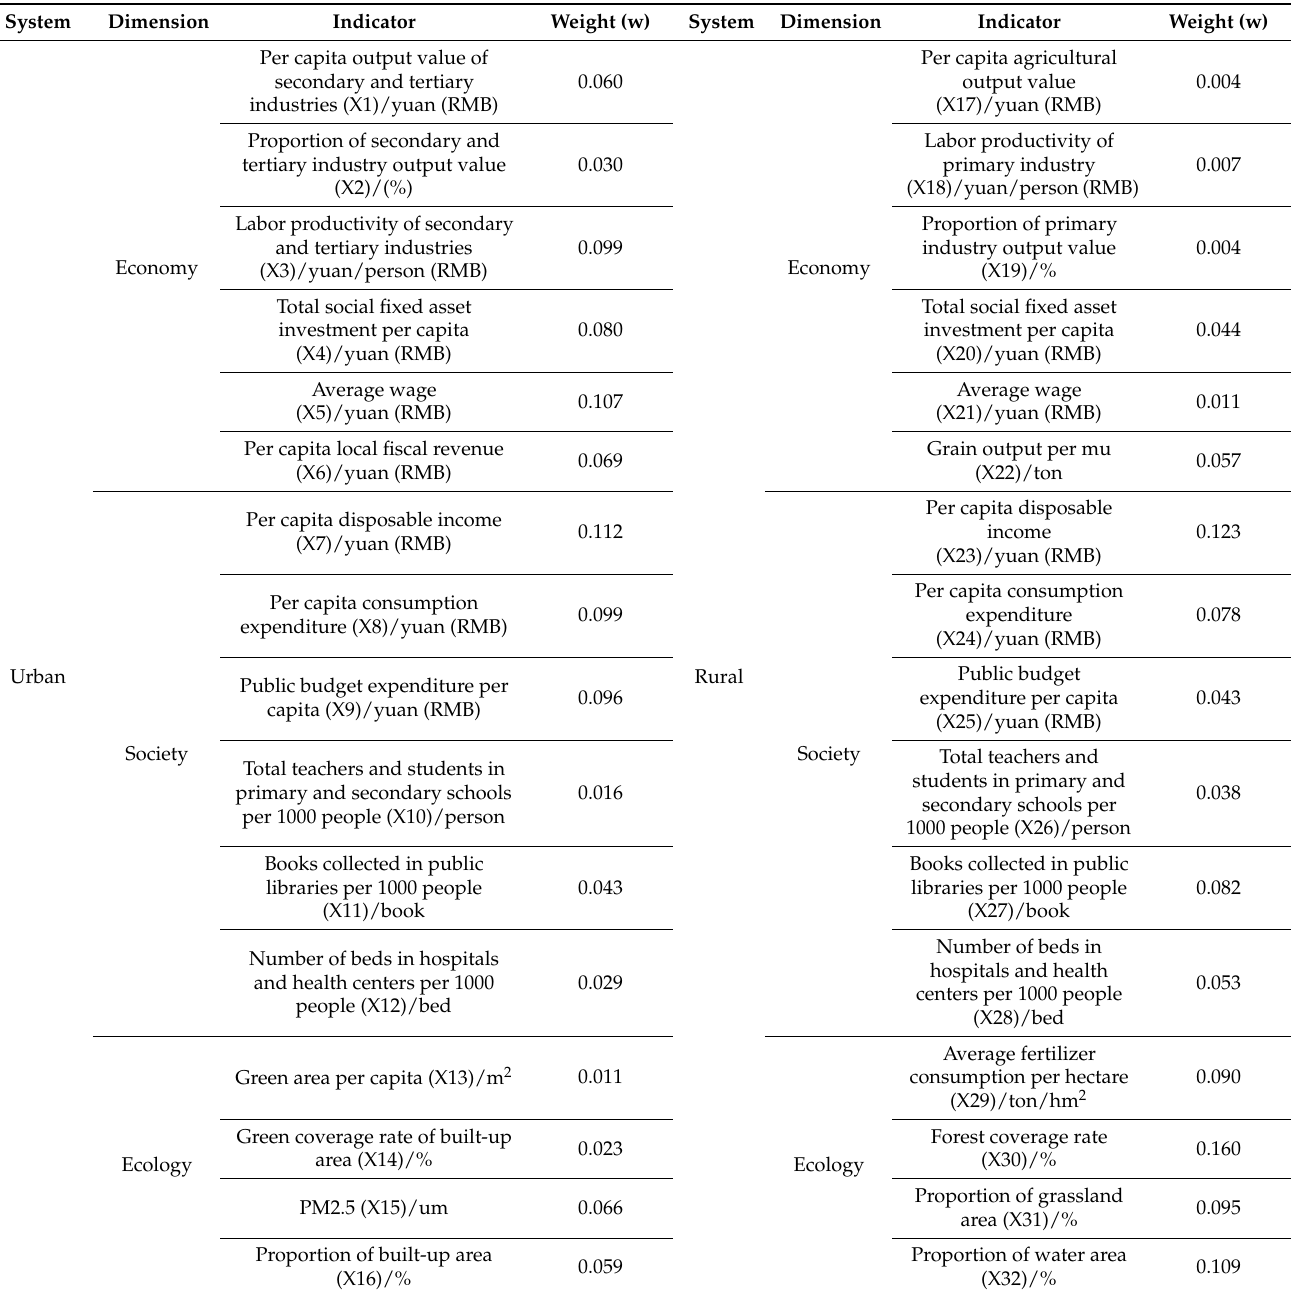
Table 1. Evaluation Index System of the Development Level of Urban–rural Integration in North- east